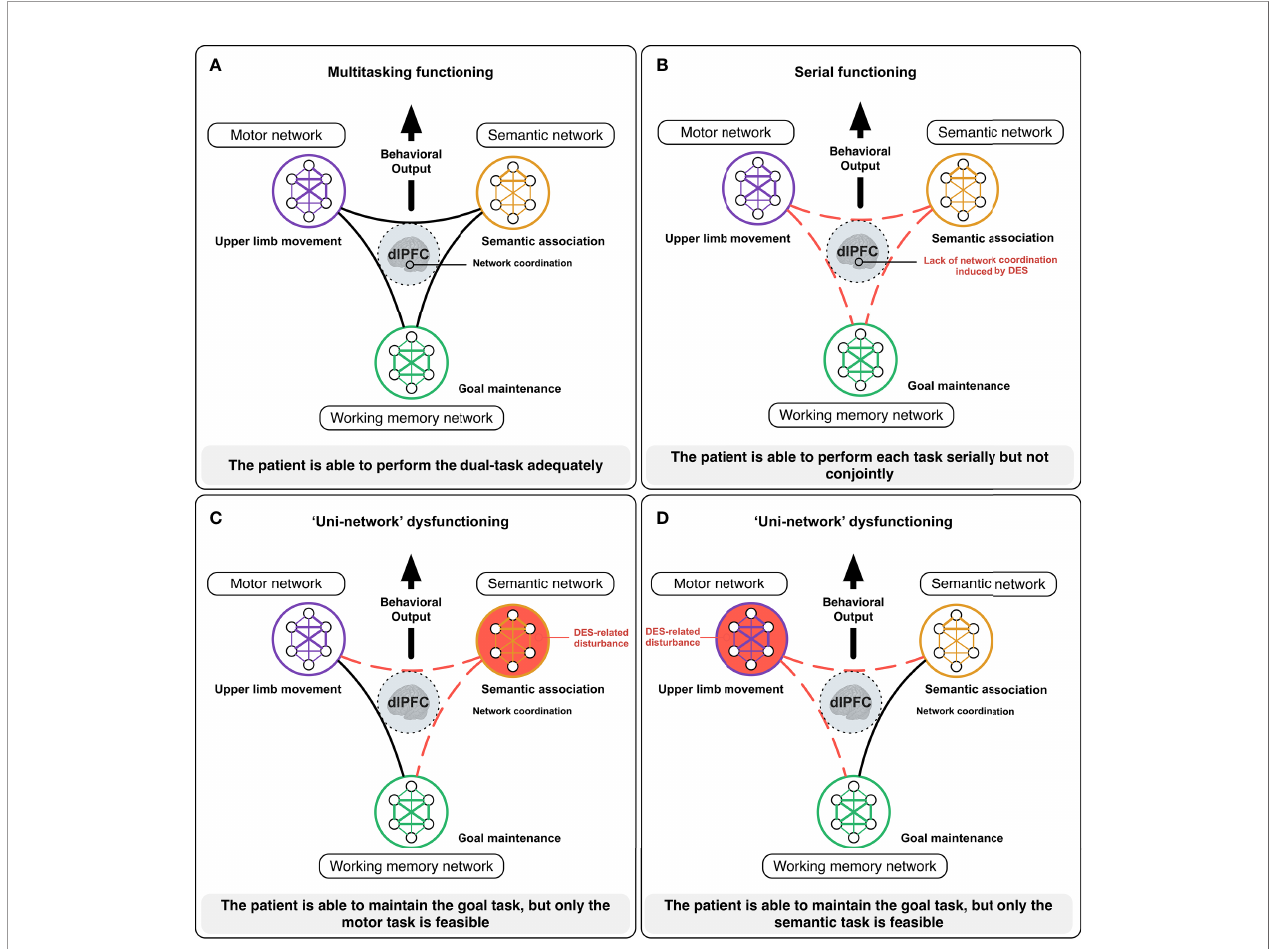
FIGURE 2 | Illustration of how DES mapping may inform on the meta-networking functioning of the brain [from (11)]. During complex cognitive activities, such as multi-tasking, the brain needs to coordinate its networks to reach the task goal. In awake surgery, the patient is here asked to achieve a dual-task consisting in performing a complex movement of the upper limb in concert with a semantic association task (PPTT). In normal circumstances (A) , the neural activity from the semantic (semantic processing), the motor (motor initiation, control, and execution) and the working memory (goal maintenance) networks needs to be integrated to perform the task ef fi ciently thanks to highly integrative hubs such as the dorsolateral prefrontal cortex (dlPFC). When the dlPFC is impaired by DES (B) , the brain has dif fi culties to coordinate its networks and the patient is only able to perform the tasks serially but not conjointly. When the semantic network is impaired by DES (C) , the patient is able to maintain the task goal, but only the motor task is performed. By contrast, when the motor network is disturbed (D) , the patient is still able to maintain the task goal, but only the semantic task is